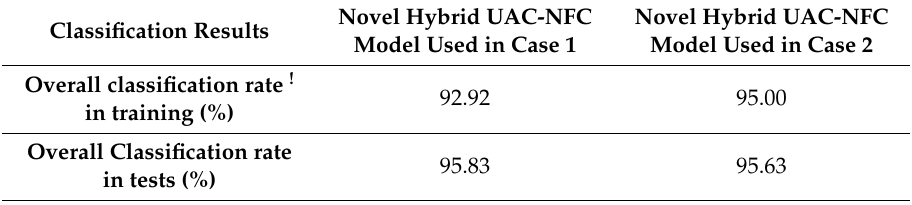
Table 4. Load classification results obtained by the novel hybrid UAC-NFC